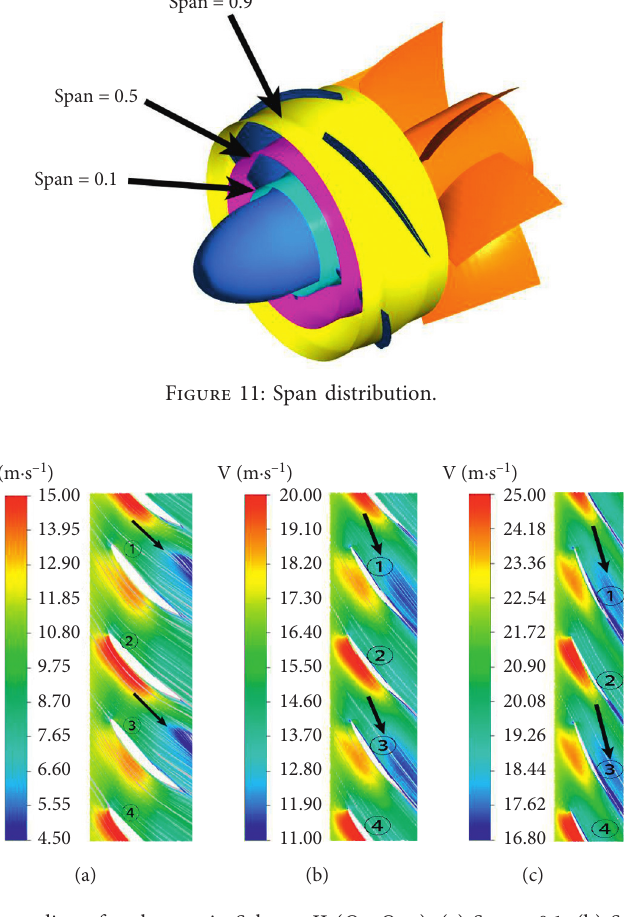
� 0.1. (b) Span � 0.5. (c) Span � 0.9. bep ). (a) Span